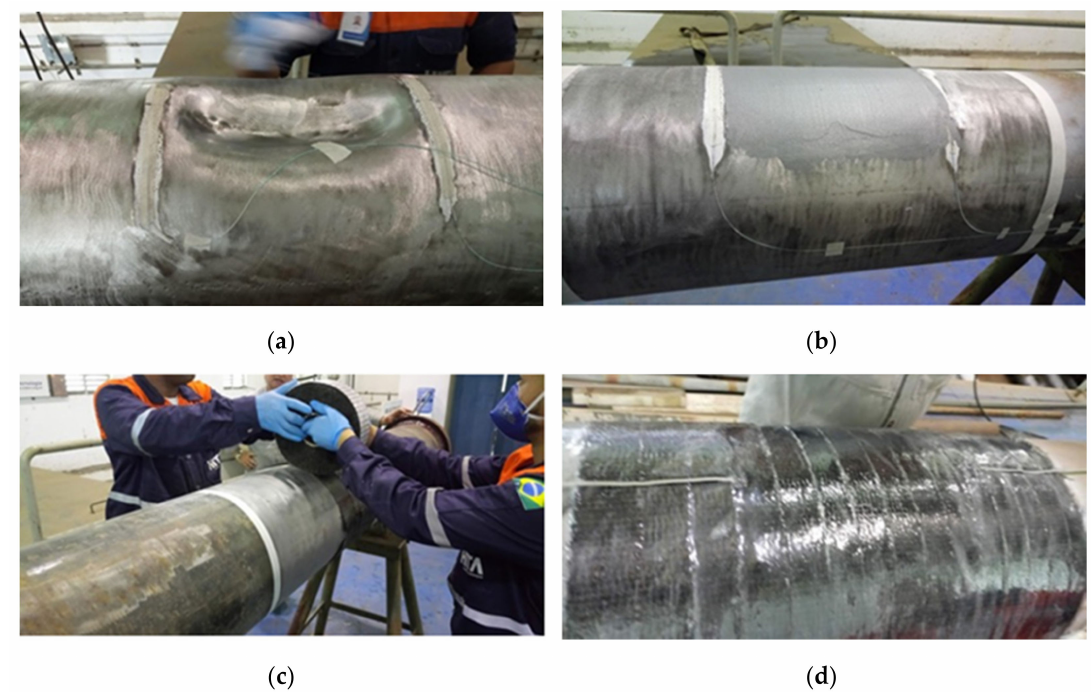
Figure 5. Stages of applying the carbon fiber repair by Supplier 3: ( a ) surface preparation, ( b ) dent is filled with epoxy resin, ( c ) composite material is added, ( d ) finished